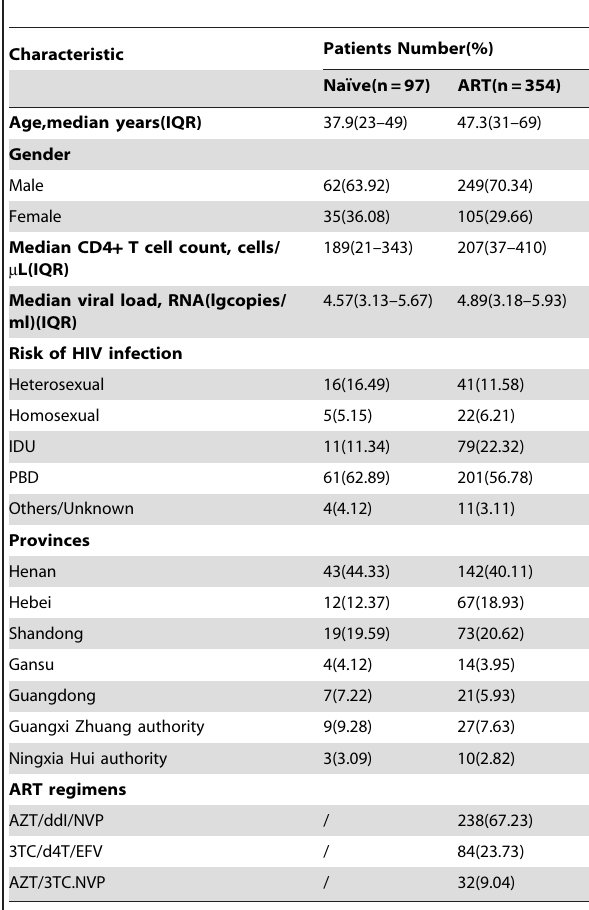
Table 1. Demographic characteristic of HIV-1 subtype B 9 patients in